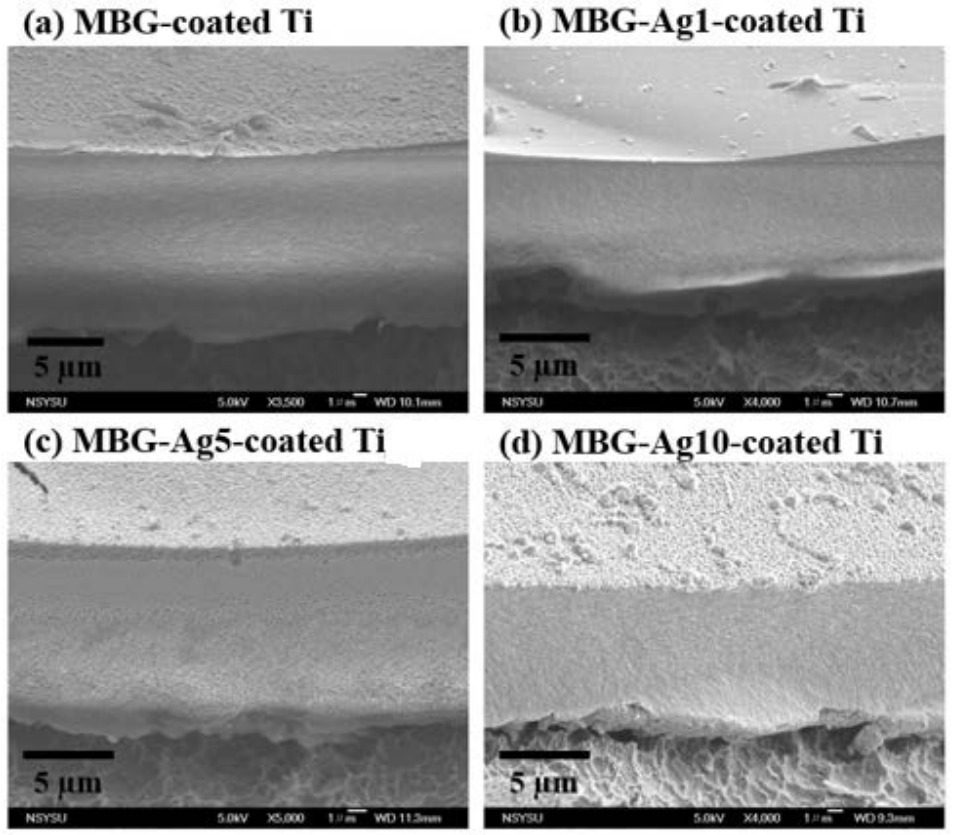
Figure 6. SEM images of ( a ) MBG–coated Ti, ( b ) MBG–Ag1–coated Ti, ( c ) MBG–Ag5–coated Ti, and ( d ) MBG–Ag10–coated Ti (N = 15).